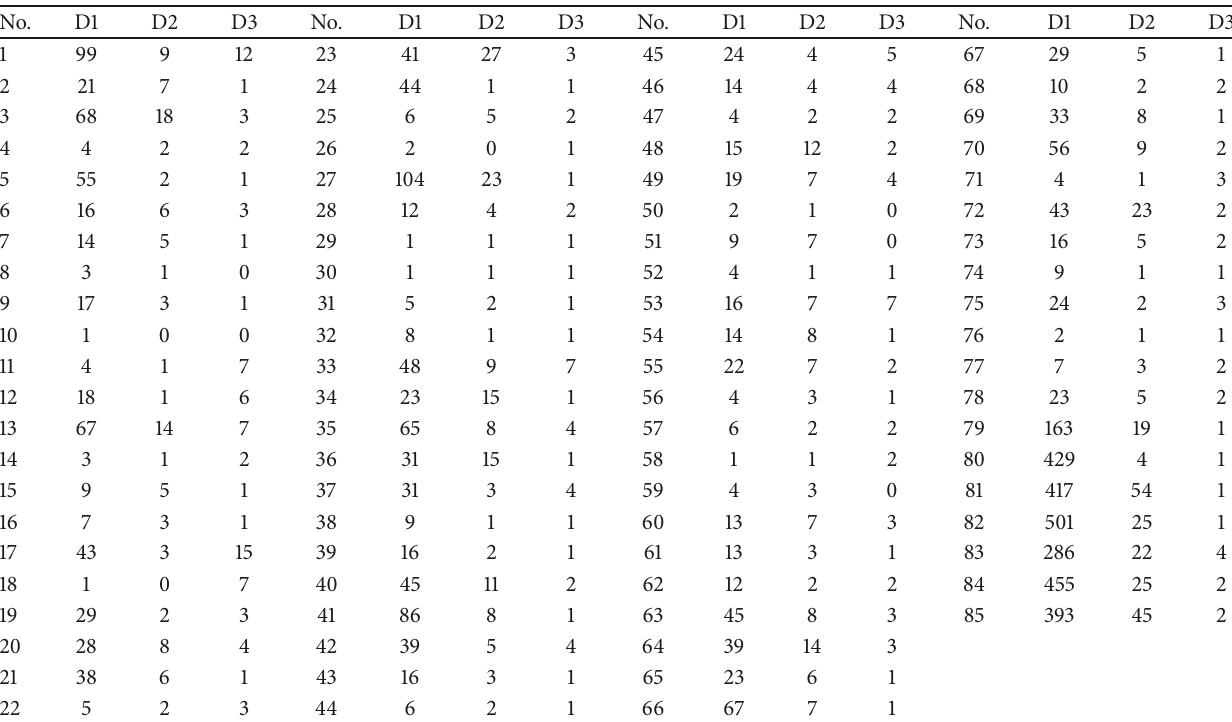
Table 3: Annual average demand of 3 products for 85